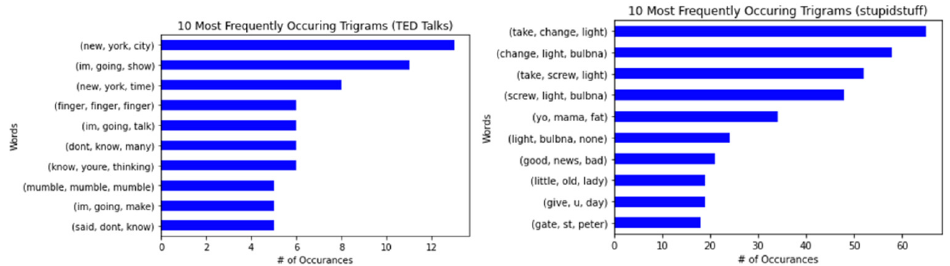
Figure 4. The 10 most frequently occurring trigrams for humorous sentences in TED Talks ( left ) and user-submitted jokes from stupidstuff.org ( right ).